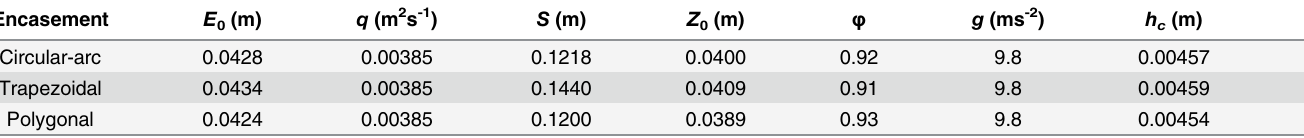
Table 4. Estimated parameters at the vena-contracta for a once-in-three-year flood event. Encasement E 0 (m) F Circular-arc Trapezoidal